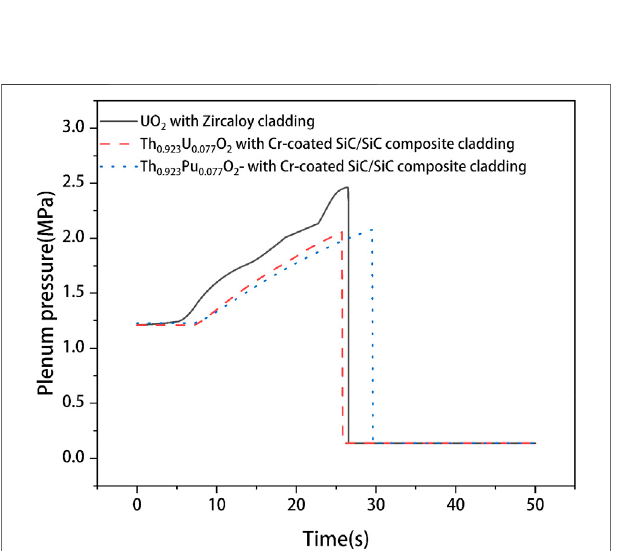
FIGURE 19 | Hoop strain evolutions for the cladding of the UO 2 fuel, the cladding of the Th 0.923 Pu 0.077 O 2 fuel, and Th 0.923 U 0.077 O 2 fuel under LOCA condition, respectively.